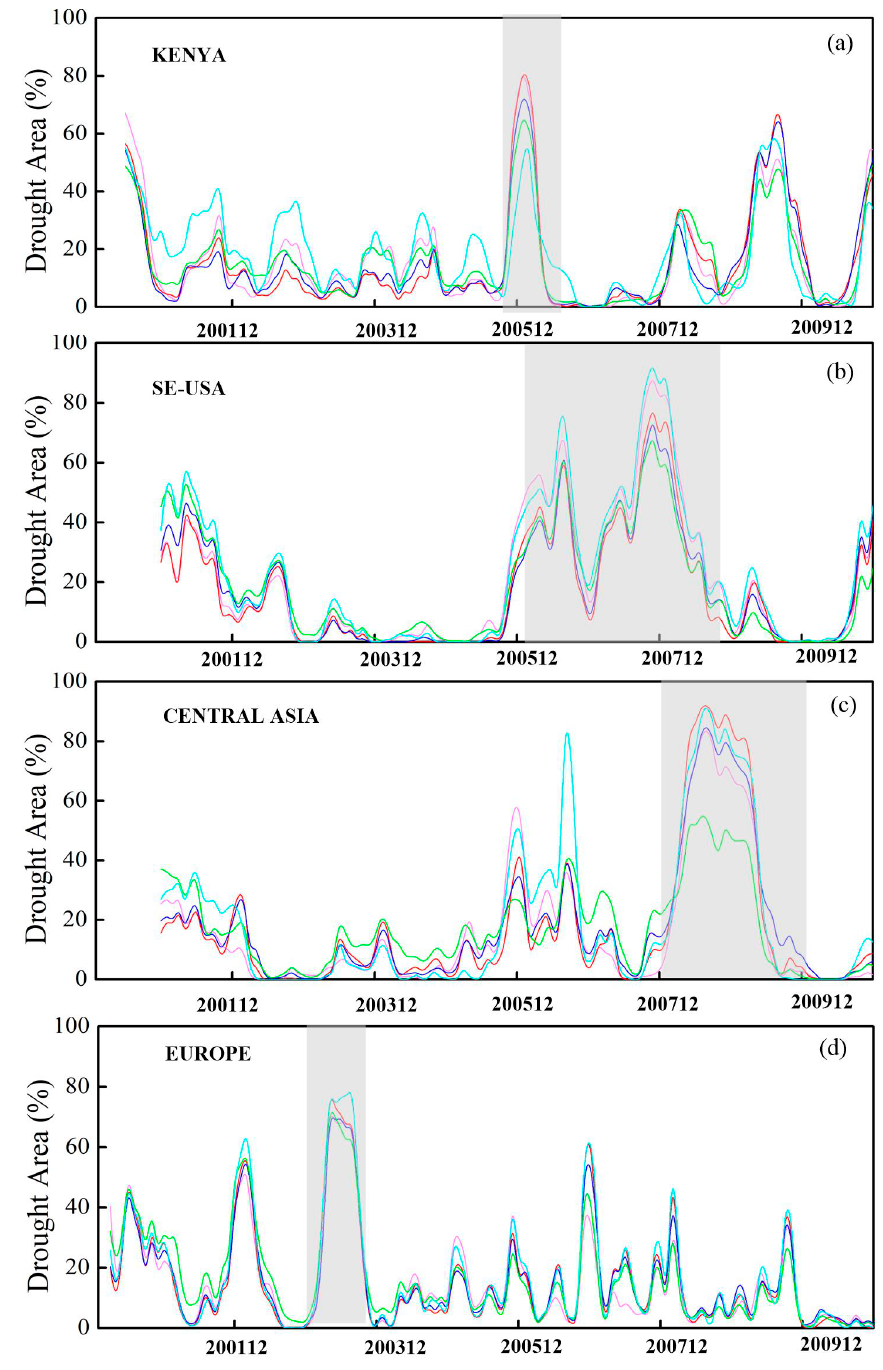
Figure 7. Drought area (%) for four drought events ( a – d ). The specific domain of the drought event is shown in Table 5.